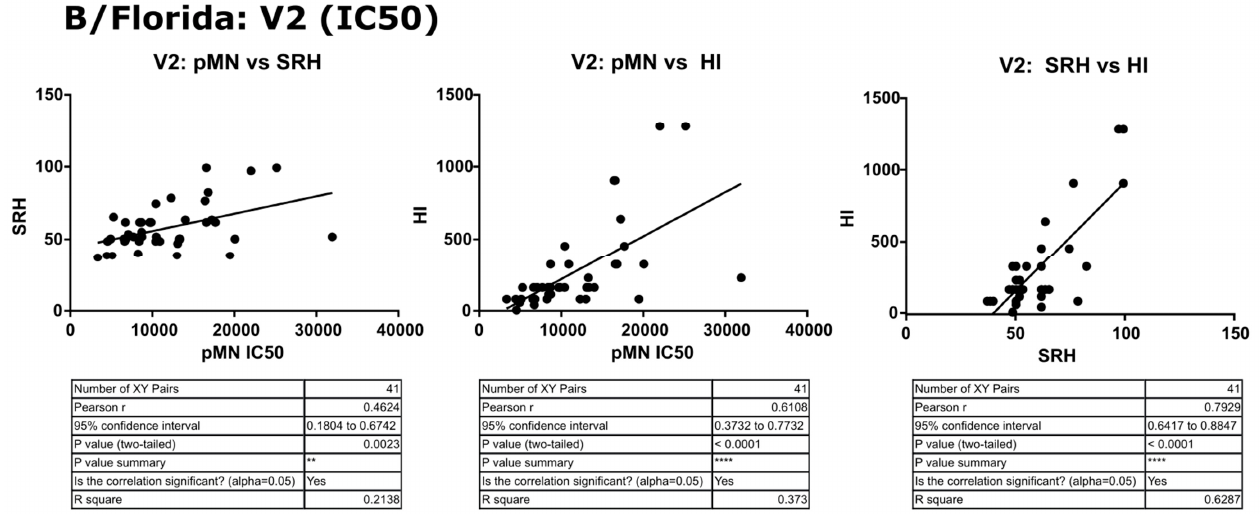
Figure 11. Correlation of SRH, HI and pMN (IC 50 ) mean V2 values assayed against B/Florida/4/2006 PV. Pearson’s two-tailed analysis performed using GraphPad Prism. Weak correlation was observed between IC 50 antibody titres and SRH (Pearsons r = 0.46). Strong correlation was observed between IC 50 antibody titres and HI (Pearsons r = 0.61), as well as between SRH and HI (Pearsons r = 0.79) for the V2 data tested. p ≤ 0.01 = **, p ≤ 0.0001 = ****.